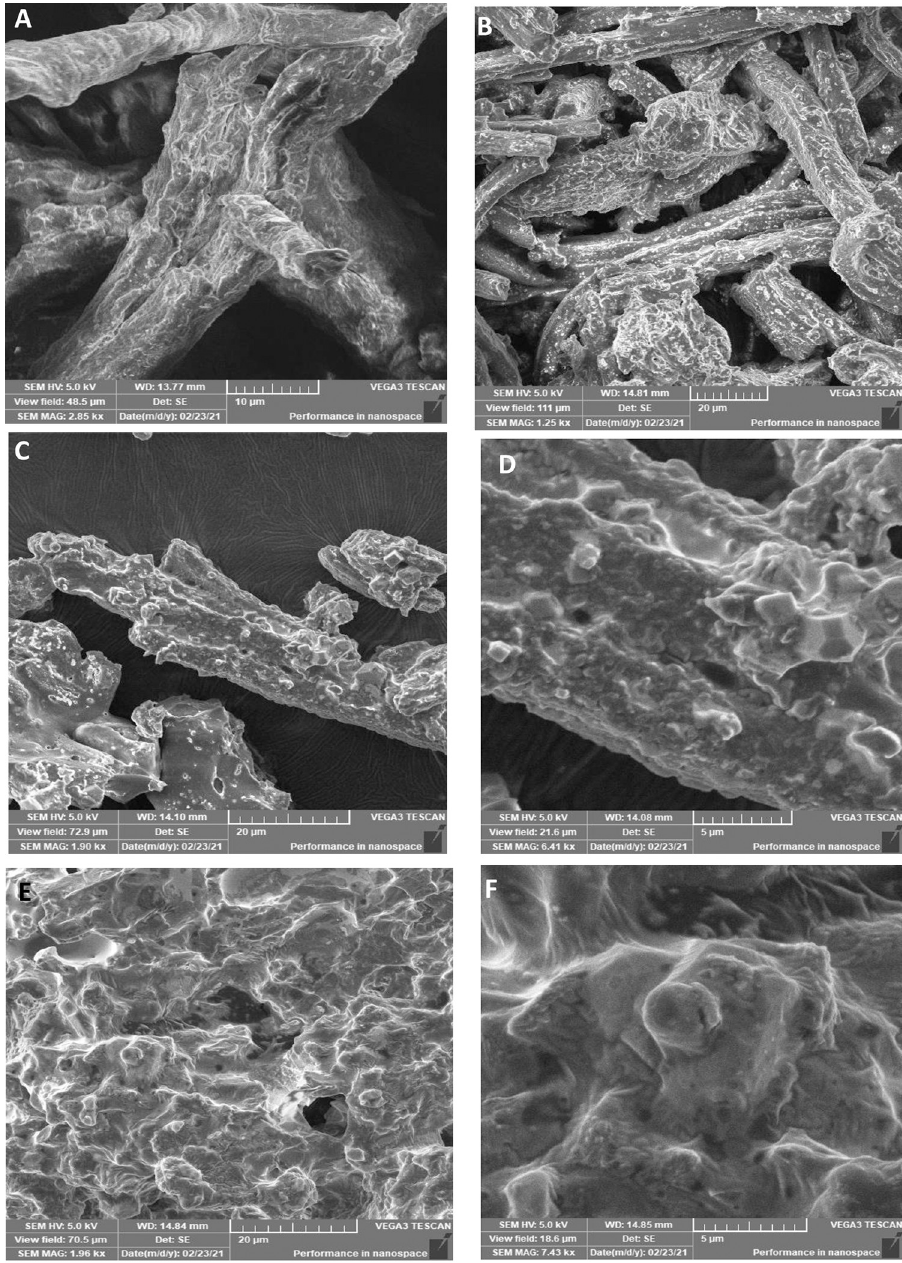
Fig 7. SEM micrographs of elastin degradation by the target elastase (Panel A represents the control, Panel B represents 1 hour of elastase treatment, Panels C and D represent 2 hours of elastase treatment, and Panels E and F represent 3 hours of elastase